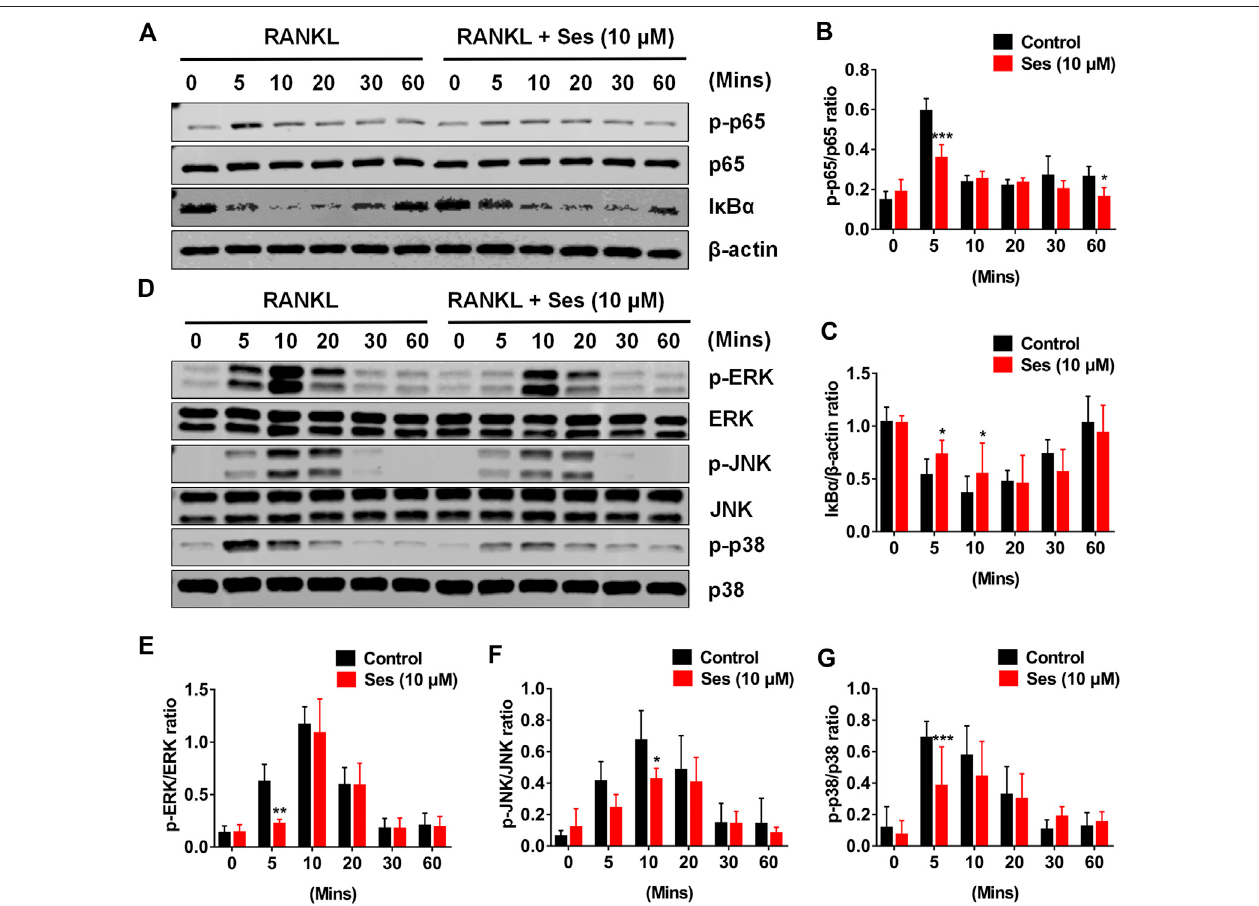
FIGURE 5 | Ses inhibits osteoclast differentiation by inhibiting the activation of NF- κ B and the MAPK signaling pathway induced by RANKL. (A) Representative Western blot images of the effect of Ses on RANKL-induced I κ B- α degradation and p65 protein phosphorylation. (B , C) The ratio of I κ B- α to β -actin and p-p65 to p65 wasquanti fi ed( n (cid:1) 3). (D) RepresentativeWesternblotimagesoftheeffectofSesontheRANKL-inducedMAPKpathway.Speci fi cantibodieswereusedtoevaluatethe protein expression and phosphorylation levels of ERK, JNK and p38. (E – G) Quanti fi cation of the ratio of phosphorylated ERK, JNK and p38 to the corresponding totalproteinband.Theabovedataareexpressedasthemean ± SD;* p < 0.05,** p < 0.01,and*** p < 0.001.Ses,sesamolin;RANKL,receptoractivatorofnuclearfactor- κ B ligand; NF- κ B, nuclear factor- κ B; MAPKs, mitogen-activated protein